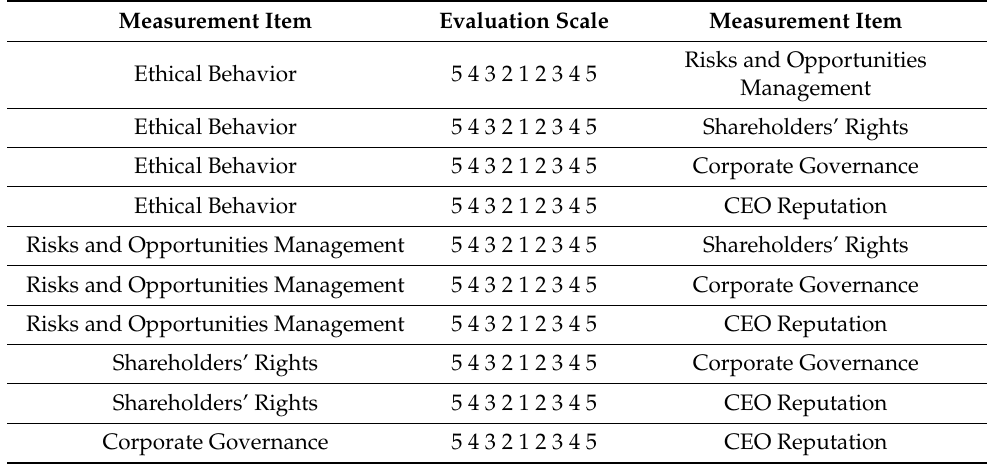
Table A10. Governance factor question